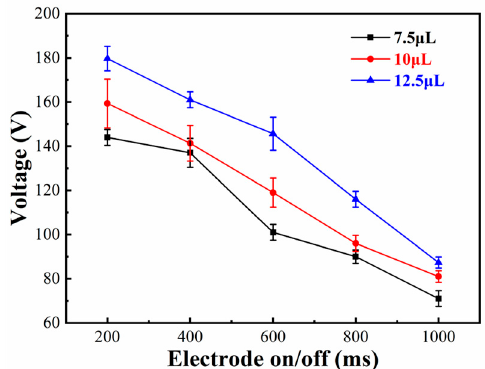
Figure 5. Curves of the relationship between the minimum driving voltage and the di ff erent electrode on / o ff times in an open EWOD device.